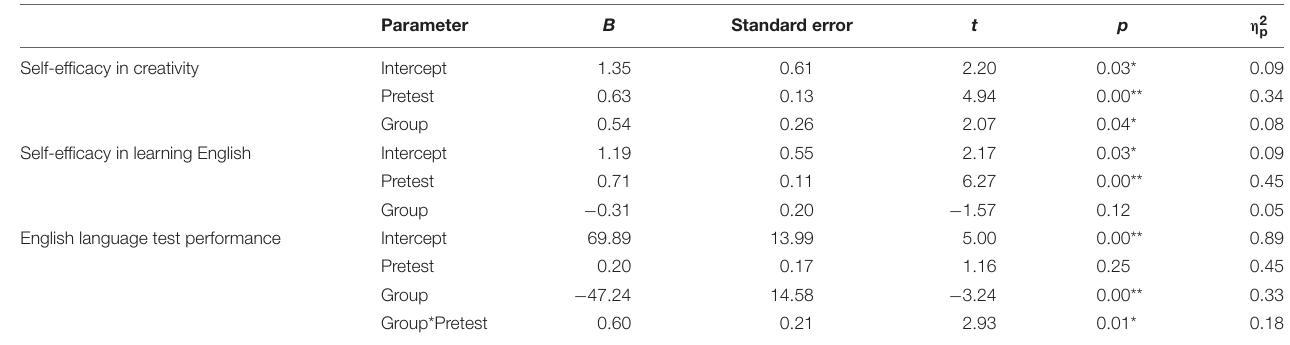
TABLE 4 | Summary of parameters of one-way ANCOVA on three outcome variables. Parameter